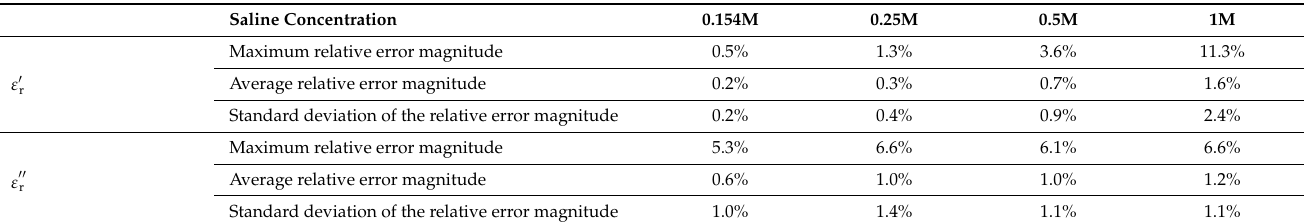
Table 2. Measurement study—relative